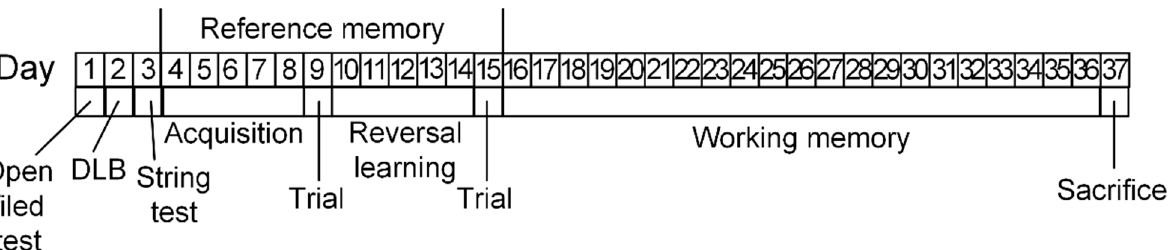
Figure 10. Timeline of the experiment. The open field was performed at the 1st day. The string test was performed at the 2nd day. The dark-light box (DLB) test was performed at the 3rd day. Morris water maze (MWM) for assessment of reference memory was performed from the 4th to the 15th day. MWM for assessment of working memory was performed from the 16th to the 36th day. Mice were sacrificed at the 37th day of experiment.